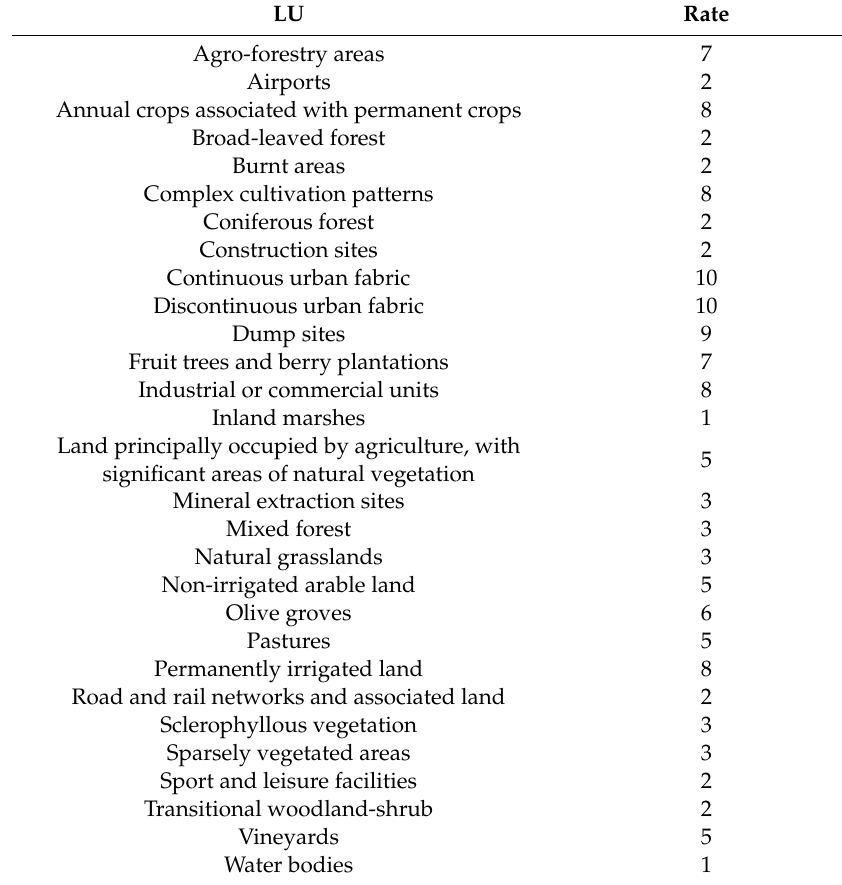
Table 1. Rates of